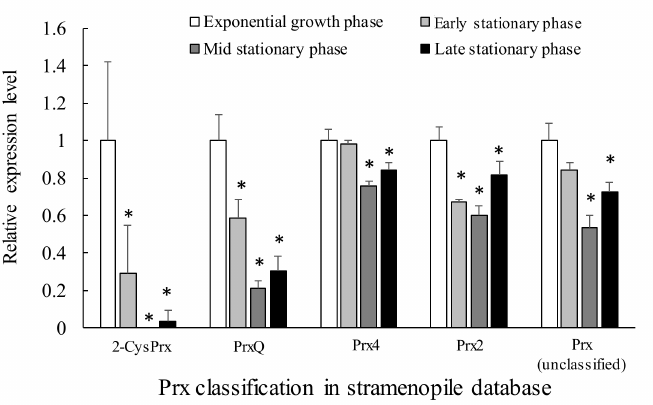
Figure 8. Relative gene expression levels based on the expression level of each gene during the exponential growth phase by RNA-seq analysis. Table 2 provides detailed descriptions of the Prx genes. Values are means ± SD of three replicates. Asterisks indicate significant differences